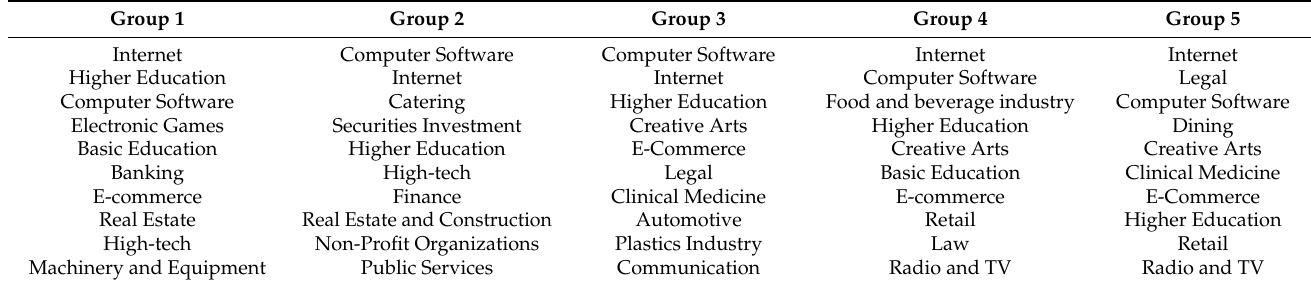
Table 8. Industry characteristics of users in each of the five